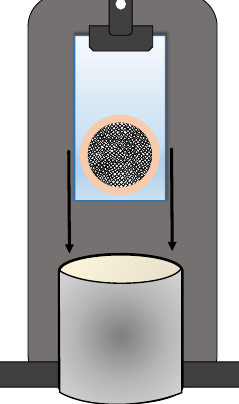
Figure 2. Schematics to the dip coating configuration and process.